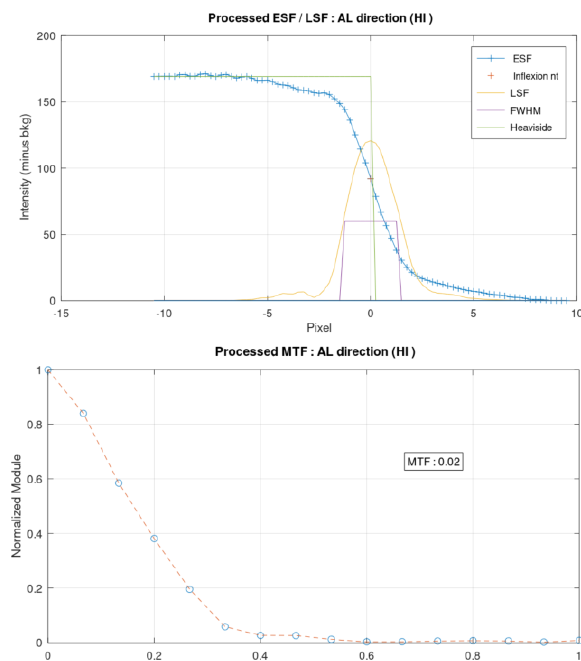
Figure 4. The ESF, LSF, FWHM, SNR, RER and MTF results over the Hl direction (along-track) from the pan band in Salon- de-Provence.